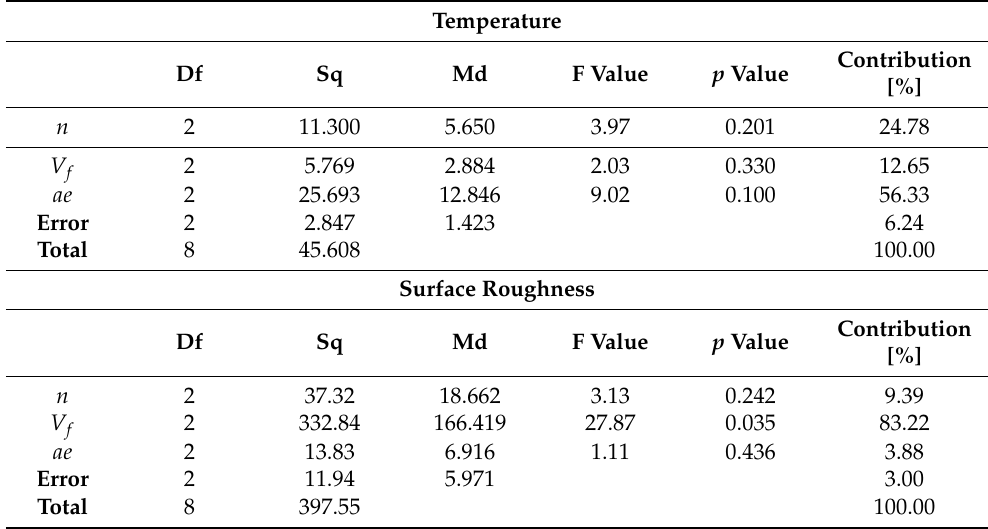
Table 13. ANOVA analysis for chip temperatures and surface roughness of the workpiece after machining tests with Balis Mafcool 51 (100 mL/h).